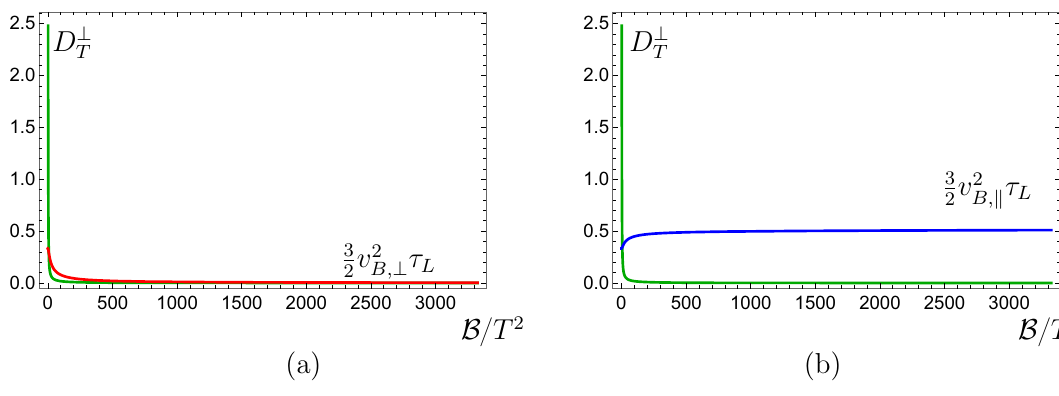
Figure 17 . (a) Eigenvalue D ? (b) Eigenvalue D ?